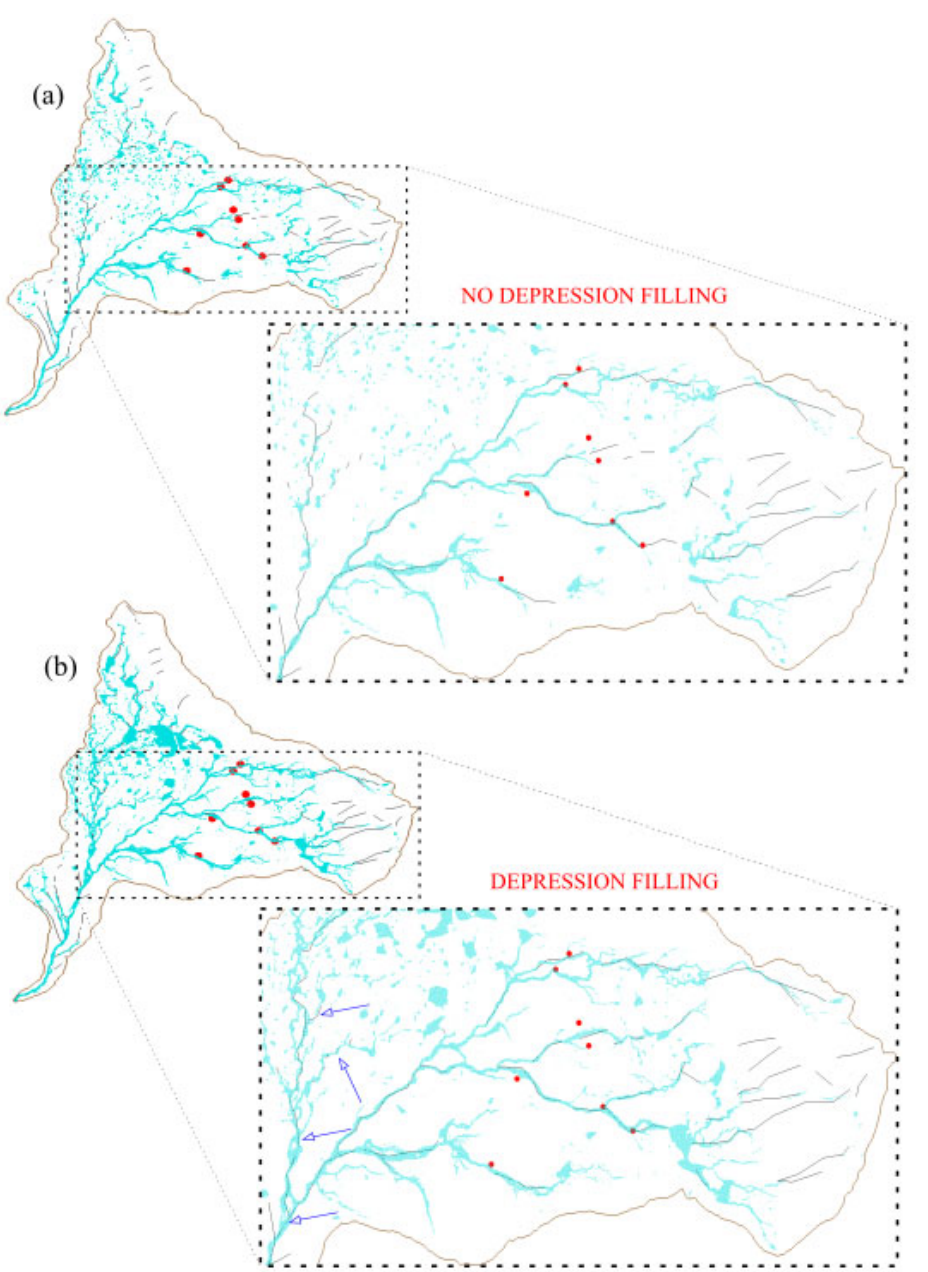
Figure 12. RC2 watershed: channel network tracked by the rain-on-grid approach using the A*-qs scaling law using the original and the filled DEM. The circles represent the channel heads location (see also the details of the figures), whereas the black continuous line is the channel network simulated by the best method considered in Orlandini et al. (2011). The blue arrows (see the zoom of the figure) highlight an artificial flow patterns induced by the depression filling